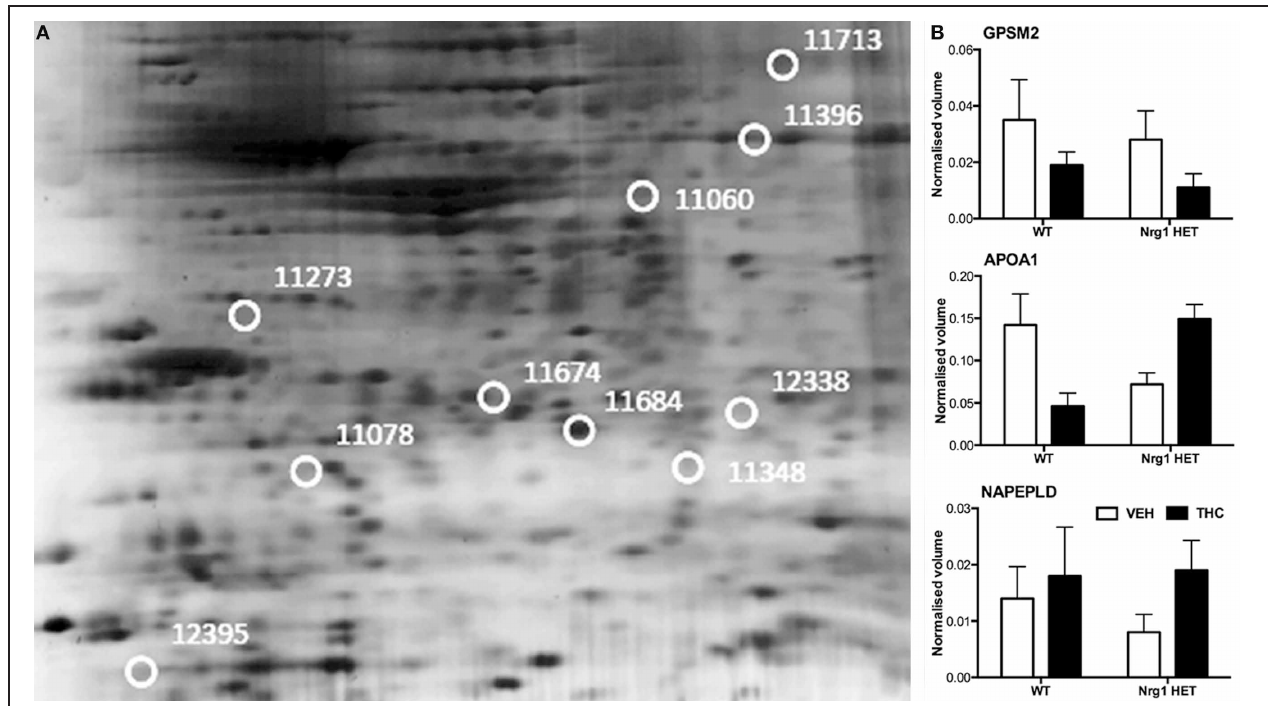
vertical axis split by molecular weight; [GPSM2 (spot 11713); APOA1 (spot 11674); NAPEPLD (spot 11060); OTOR (spot 12395)]; and